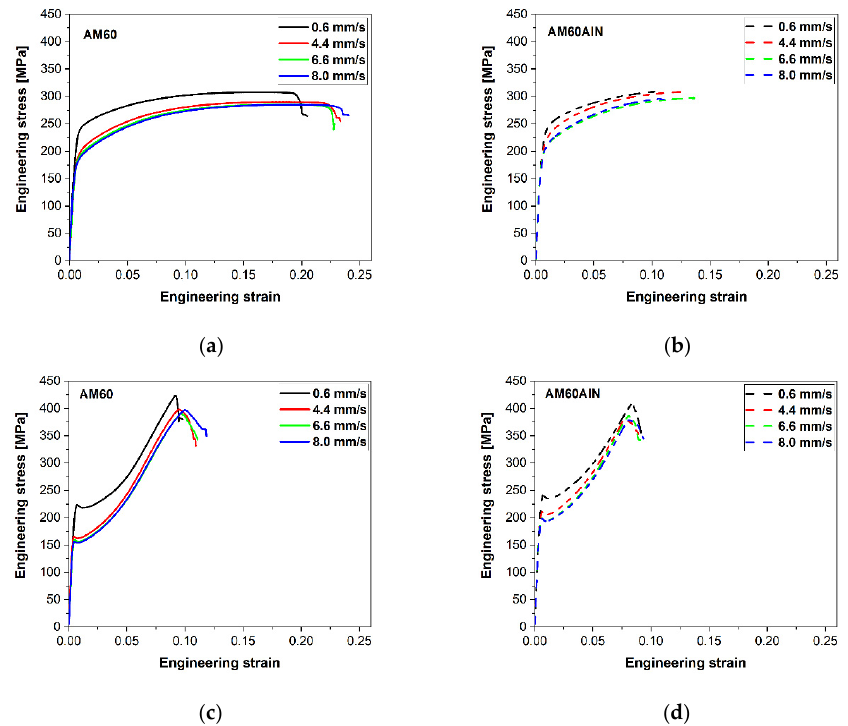
Figure 5. Stress–strain diagrams of extruded bars of AM60 ( a , c ) and AM60 with 1 wt.% AlN ( b , d ) in tension ( a , b ) and compression ( c , d ).